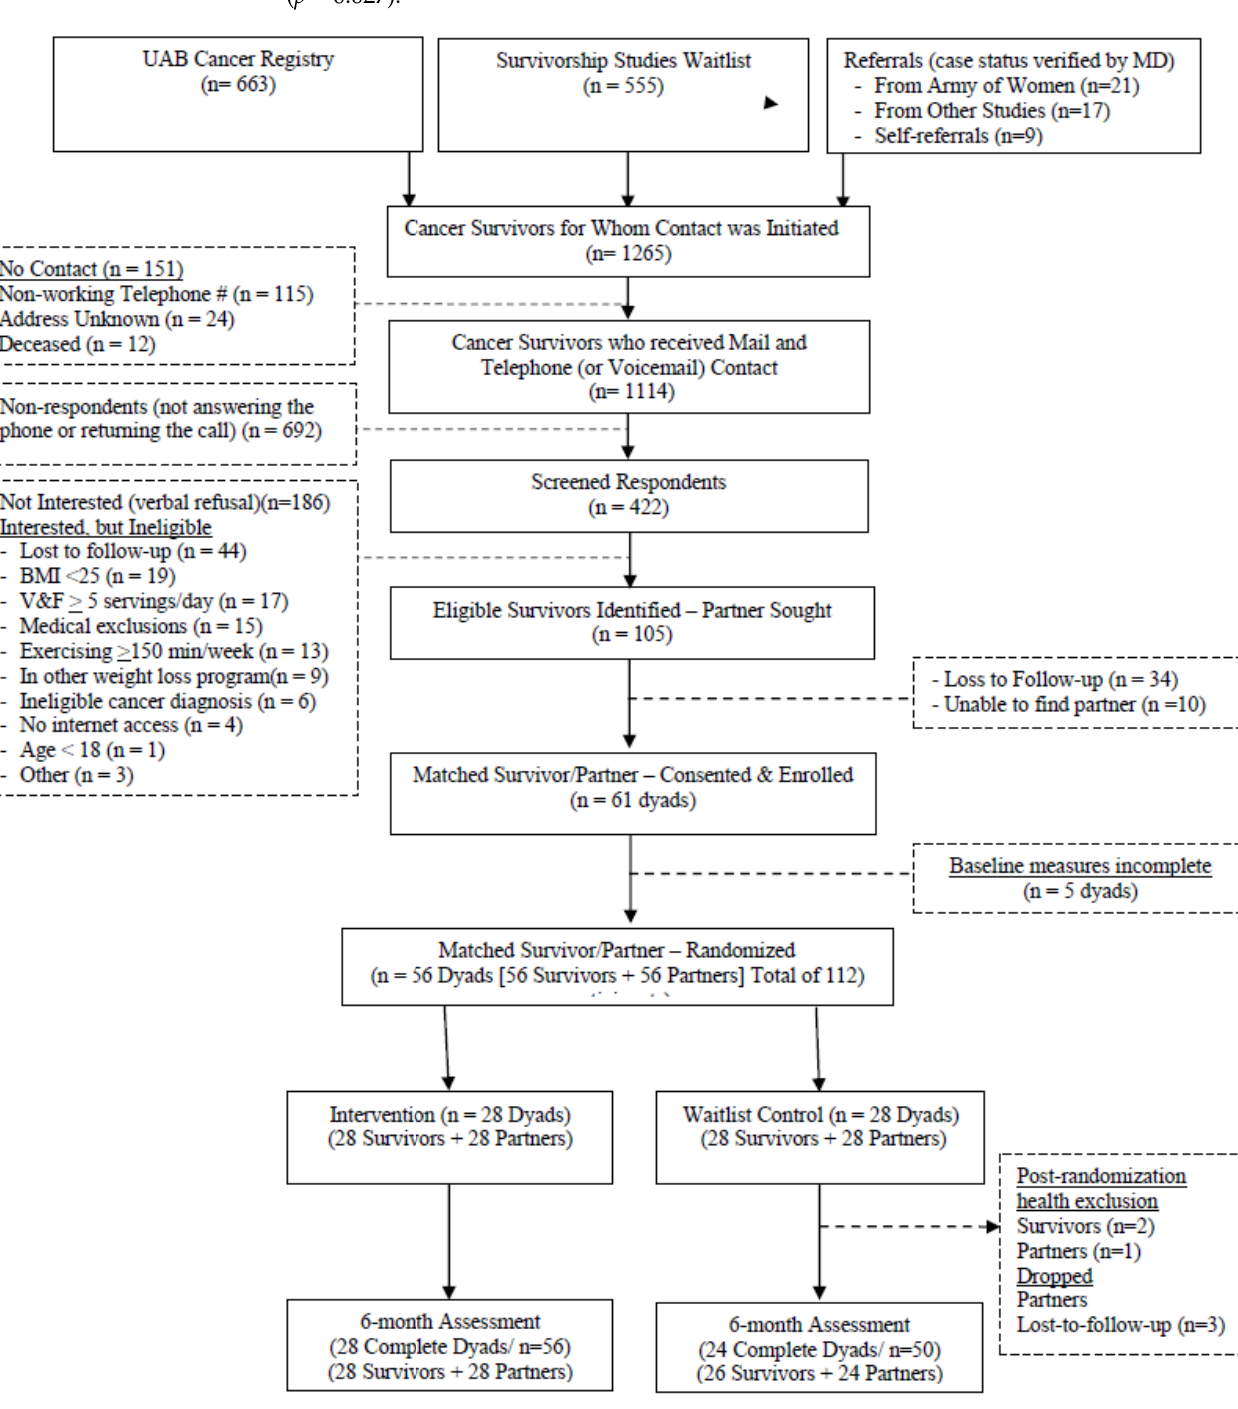
Table 2. Baseline to 6-m differences in adiposity, diet, and physical activity in waitlist vs. DUET intervention study arms.